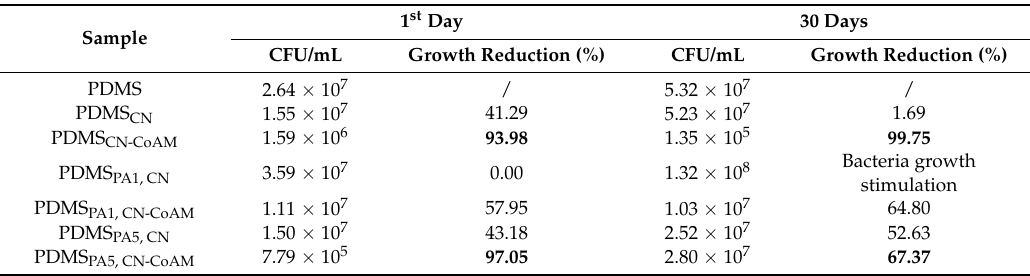
Table 5. Microbiological results of reduced bacterial growth by different silicone samples at different time points/after four hours of exposure.